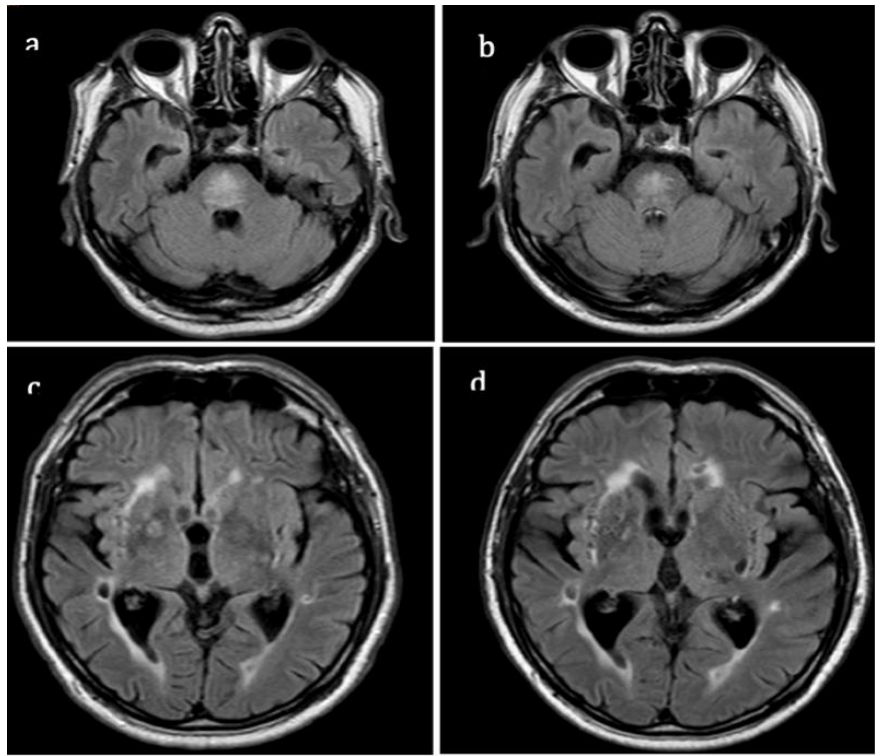
Figure 2. MRI fluid-attenuated inversion recovery (FLAIR) in 2007 ( a , c ) and in 2014 ( b , d ).